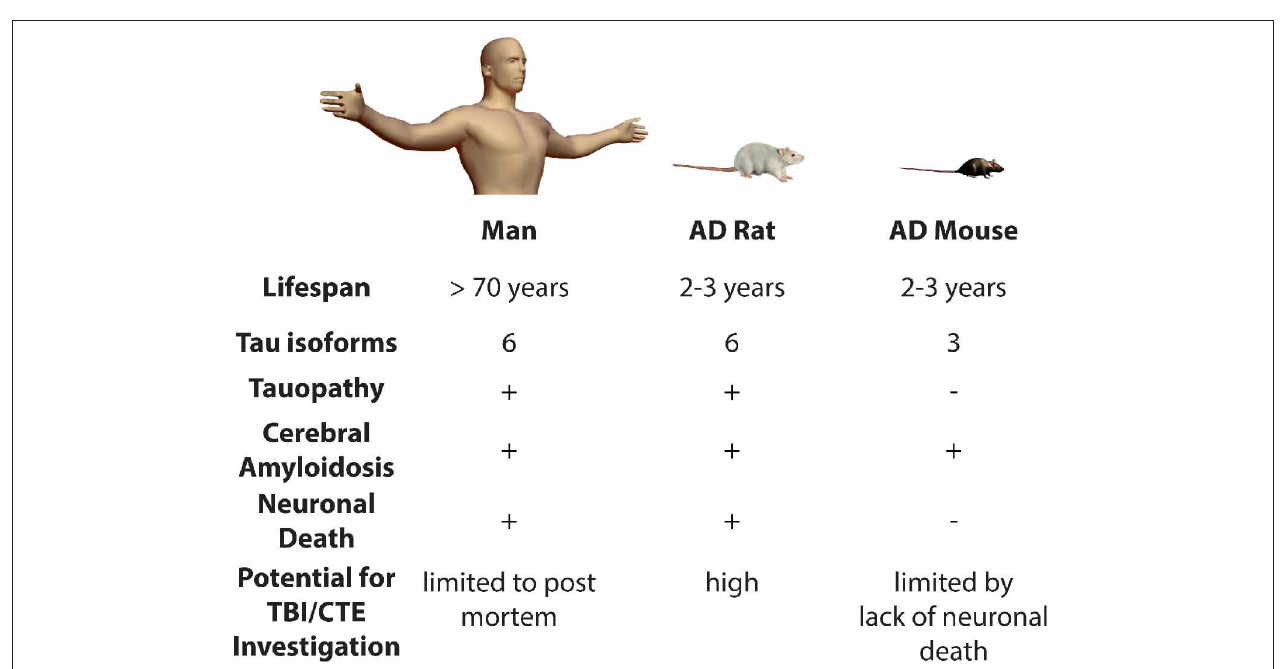
FIGURE 1 | Modeling the risk relationship between traumatic brain injury and Alzheimer’s disease. Presence ( + ) or absence ( − ) of various pathological features is indicated. AD, Alzheimer’s disease; TBI, Traumatic Brain Injury; CTE, Chronic Traumatic